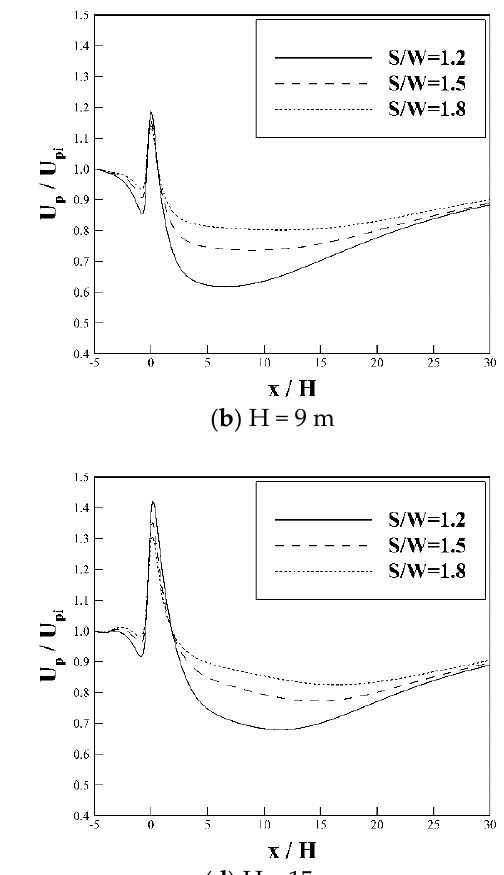
Figure 13. Pedestrian wind speed contours for different tree spaces (H = 15 m).